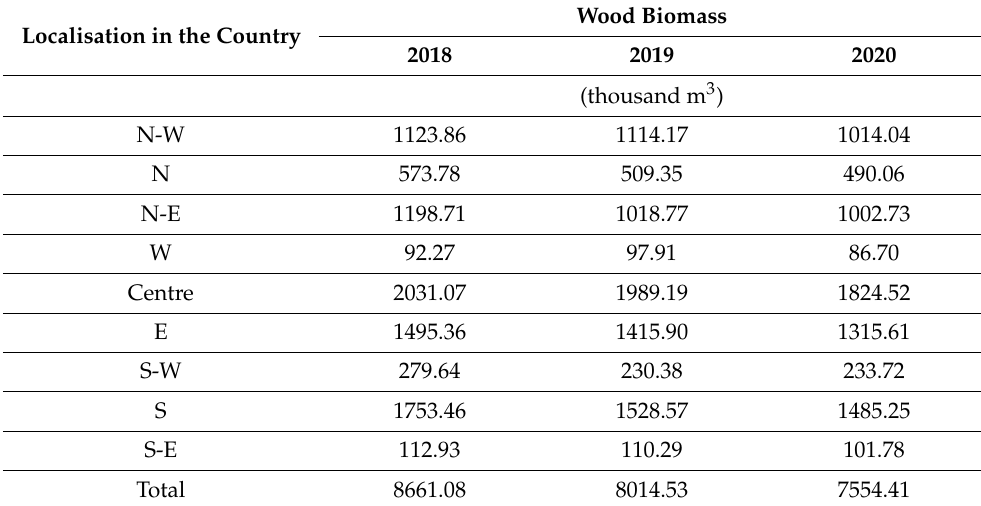
Table 6. The amounts of sawmill biomass generated in different locations in Poland.